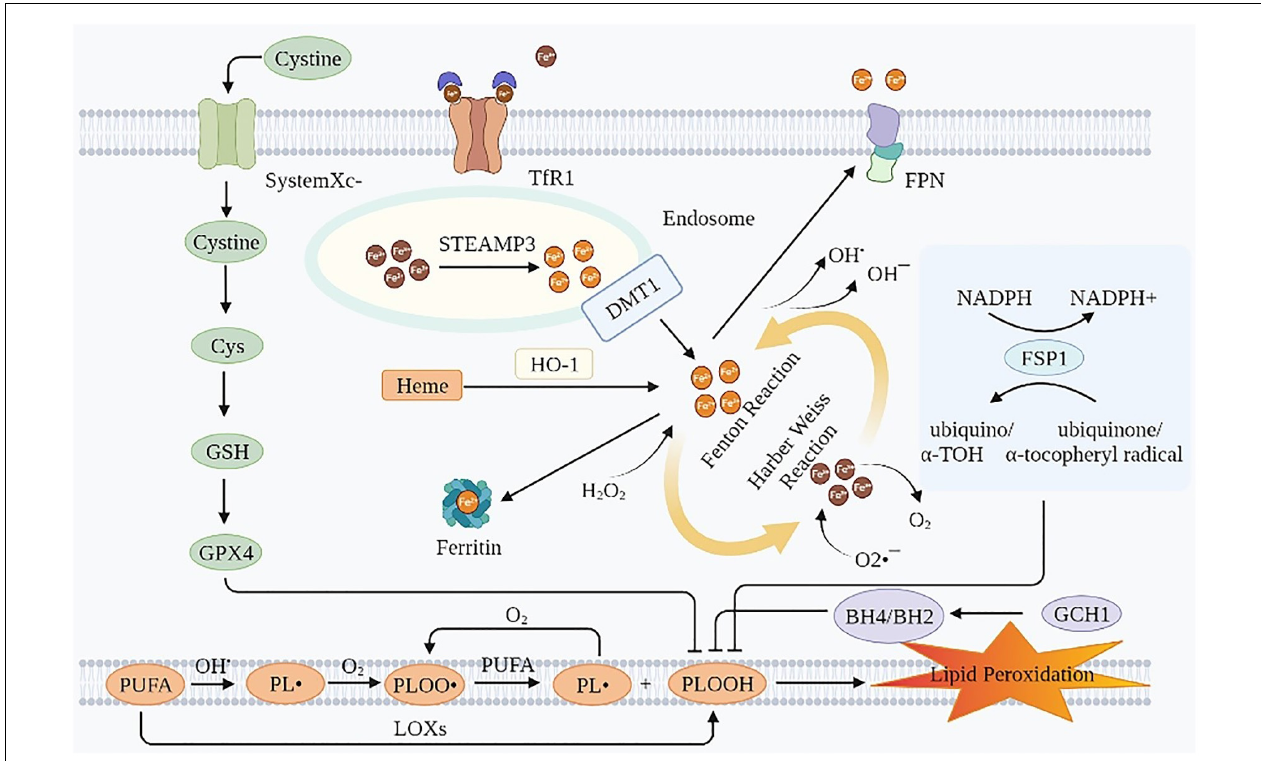
FIGURE 1 | Mechanisms of ferroptosis. Ferroptosis is essentially an iron-dependent lipid peroxidation. Intracellular iron overload is a necessary condition for ferroptosis, and lipid peroxidation is the presentation form of ferroptosis. TfR1, transferrin receptor 1; FPN, ferroportin; Cys, cysteine; GSH, glutathione; GPX4, glutathione peroxidase 4; STEAP3, six-transmembrane epithelial antigen of the prostate 3; DMT1, divalent metal transporter 1; HO-1, heme oxygenase 1; NADPH, nicotinamide adenine dinucleotide phosphate; FSP1, ferroptosis suppressor protein 1; PUFA, polyunsaturated fatty acids; GCH1, GTP cyclohydrolase-1; BH4/BH2, tetrahydrobiopterin/dihydrobiopterin; LOXs, lipoxygenases; PL • , phospholipid radical; PLOO • , phospholipid peroxyl radical; PLOOH, phospholipid hydroperoxide; α -TOH, α